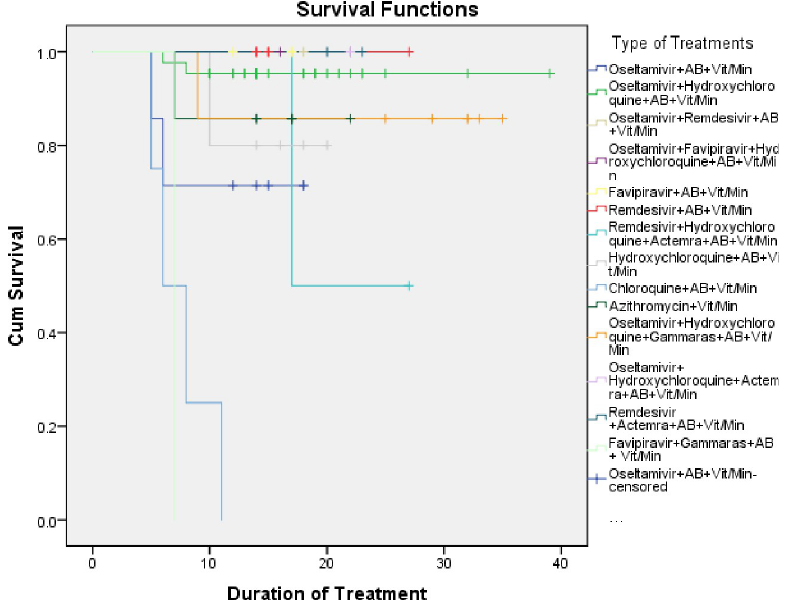
Fig 1. Kaplan meier survival for COVID-19 patients based on the medical treatments received.